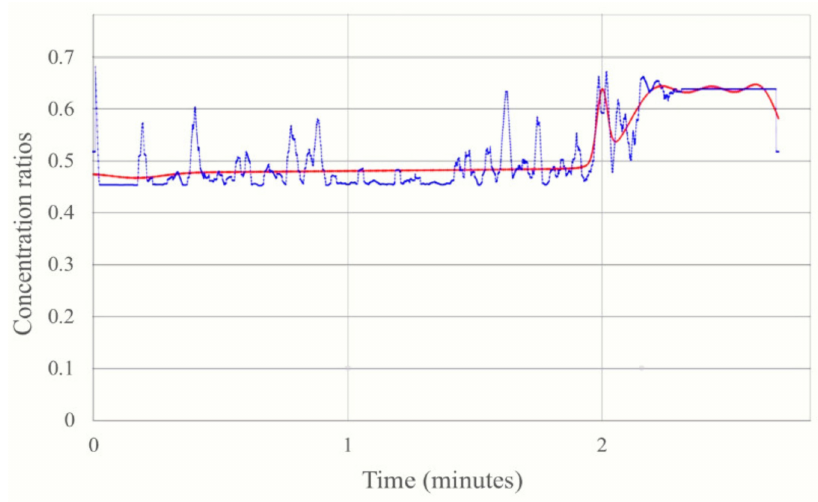
Figure 15. CRF value for alumina at flow rates of 1.9 × 10 − 2